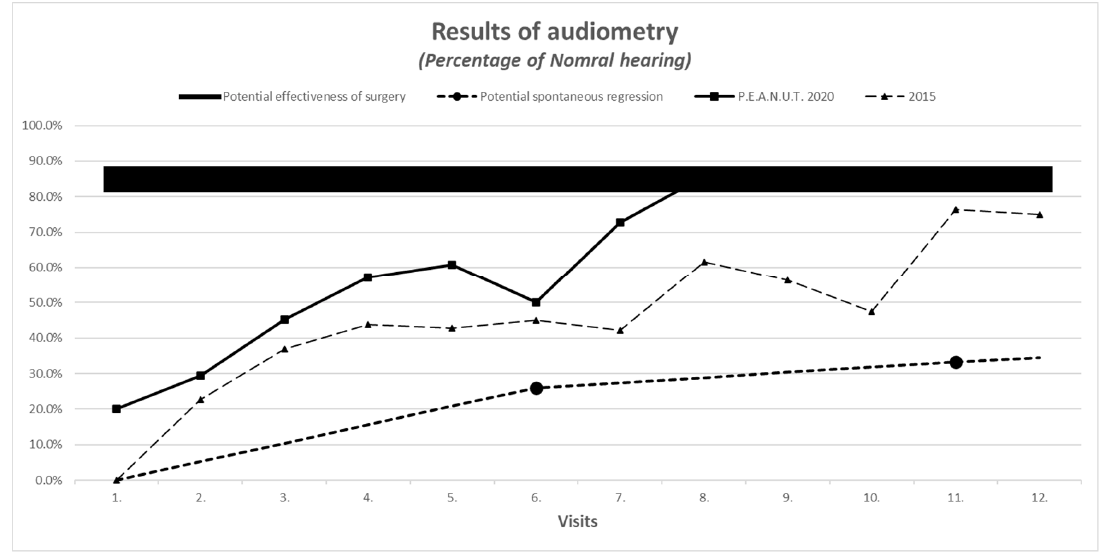
Figure 2. Improvement in audiometric measurement.